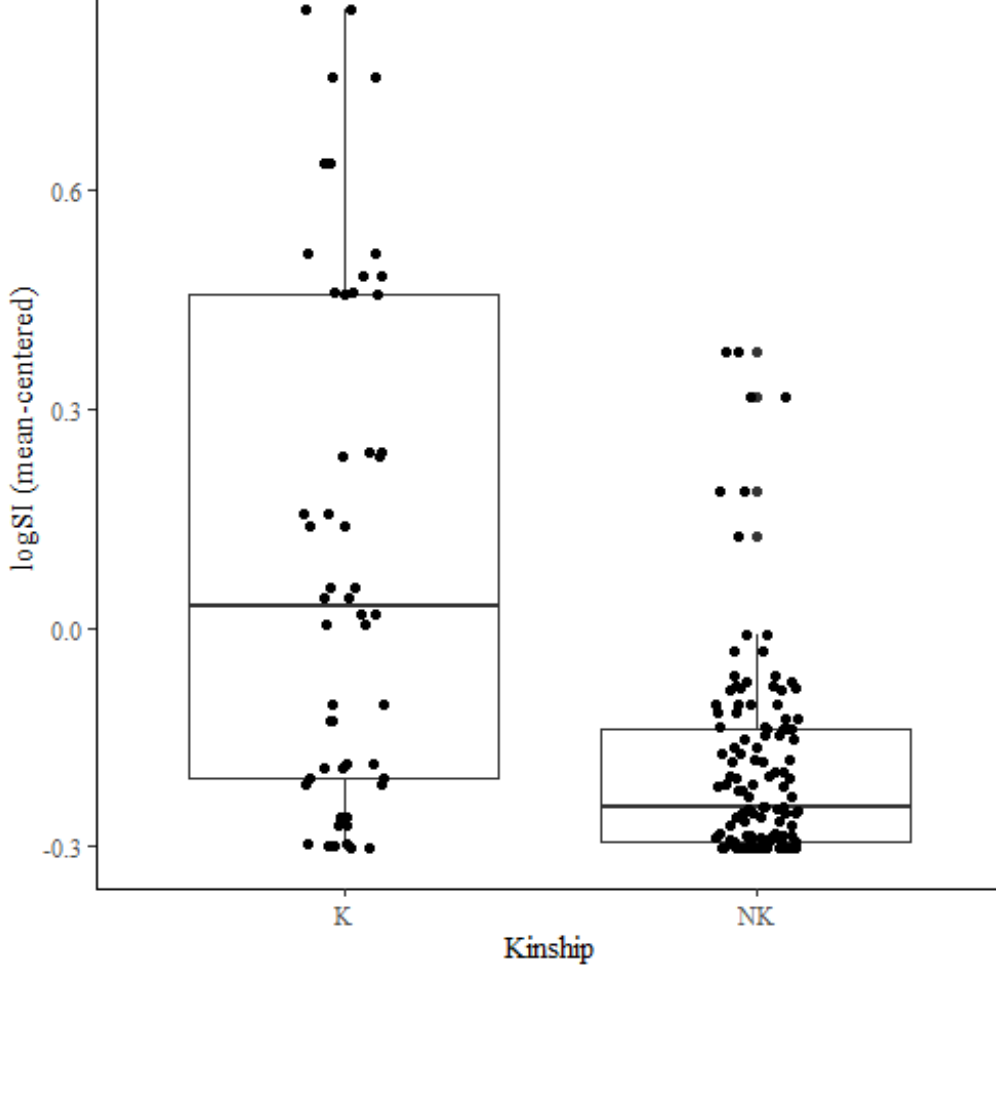
Boxplot Depicting the Effect of Kinship on Relationship Quality (Measures as Mean-Centered logSI). K=Kin,